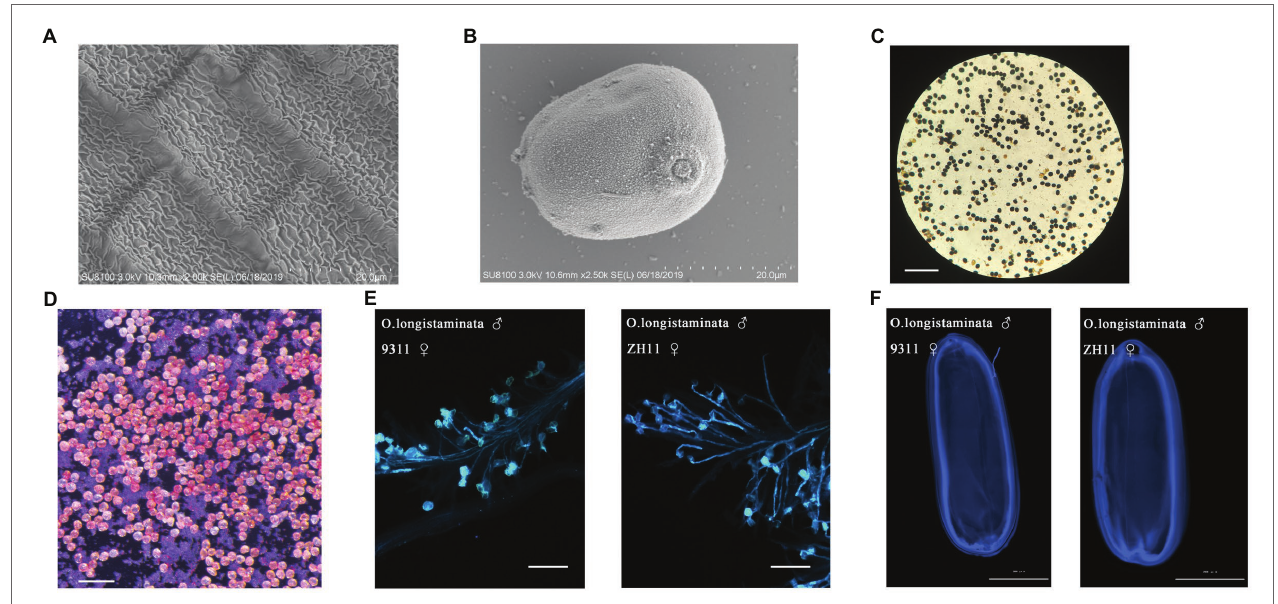
FIGURE 2 | Cytological analysis of pollen development in O. longistaminata . (A) Scanning electron microscope observation of the anther cuticle in O. longistaminata . Bars = 20 μm. (B) Scanning electron microscope observation of pollen grains in O. longistaminata . Bars = 20 μm. (C) I2-KI staining of pollen. Bars = 200 μm. (D) Triphenyltetrazolium chloride (TTC) staining of pollen. Bars = 100 μm. (E) Pollen tube growth of O. longistaminata on the stigmas of 9311 and ZH11. Bars = 100 μm. (F) The pollen tube imprinting of O. longistaminata on mature embryos of 9311 and ZH11. Bars = 2,000